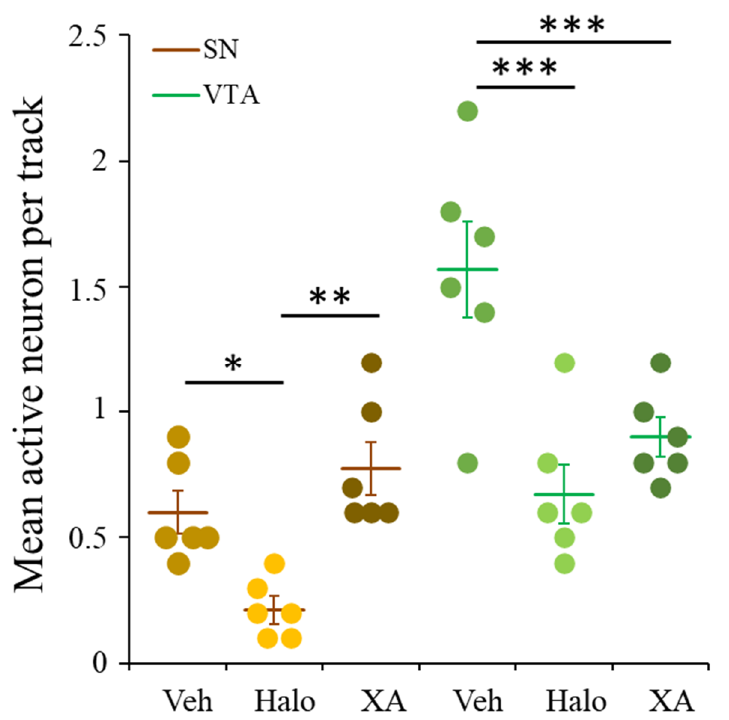
Figure 6. XA and haloperidol chronic effect on VTA and SN spontaneous neuronal firing. Three groups of six rats were daily i.p injected with vehicle, haloperidol (0.5 mg/kg) or XA (100 mg/kg) in 1 mL volume, respectively for 21 days and recorded at D22 in the conditions given in the methods section. Each of the data point (circles) represents the average number of active neurons found in the tracks explored per rat for left and right SN or VTA, respectively. Bar chart histogram of the mean (±SEM) data for the six rats per condition. * p < 0.05; ** p < 0.01 ; *** p < 0.001 Statistical significance obtained with one-way ANOVA followed by Newman-Keuls multiple comparison test for VTA. For SN data, since the Veh-group did not pass the normality test, the non-parametric statistical Mann-Whitney test was used to compare the Halo-group to the Veh- and XA-group.